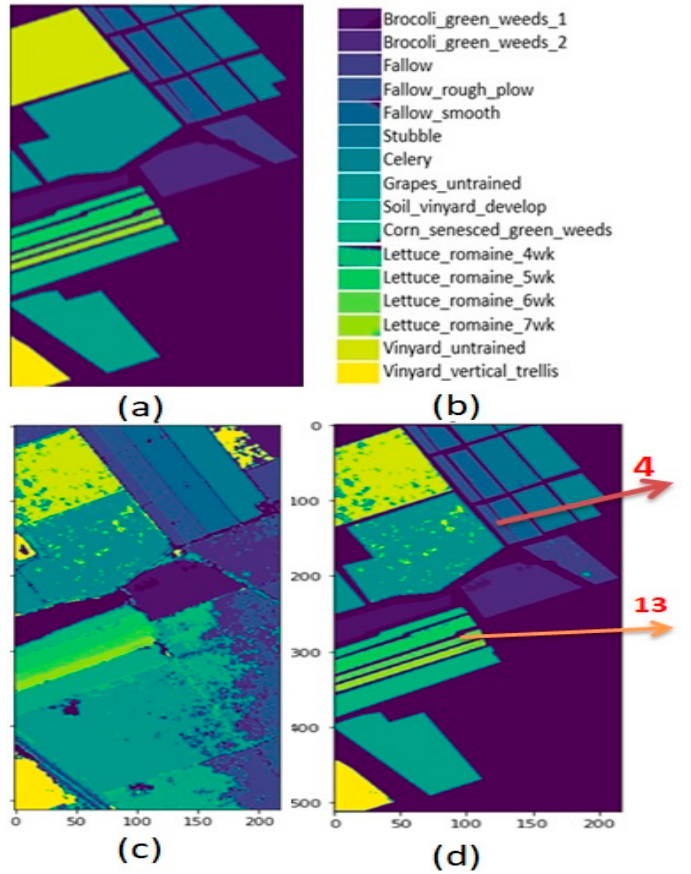
Figure 9. Salinas data ( a ) Ground truth ( b ) Category label ( c ) Crop classification result on entire data ( d ) Crop classification result.